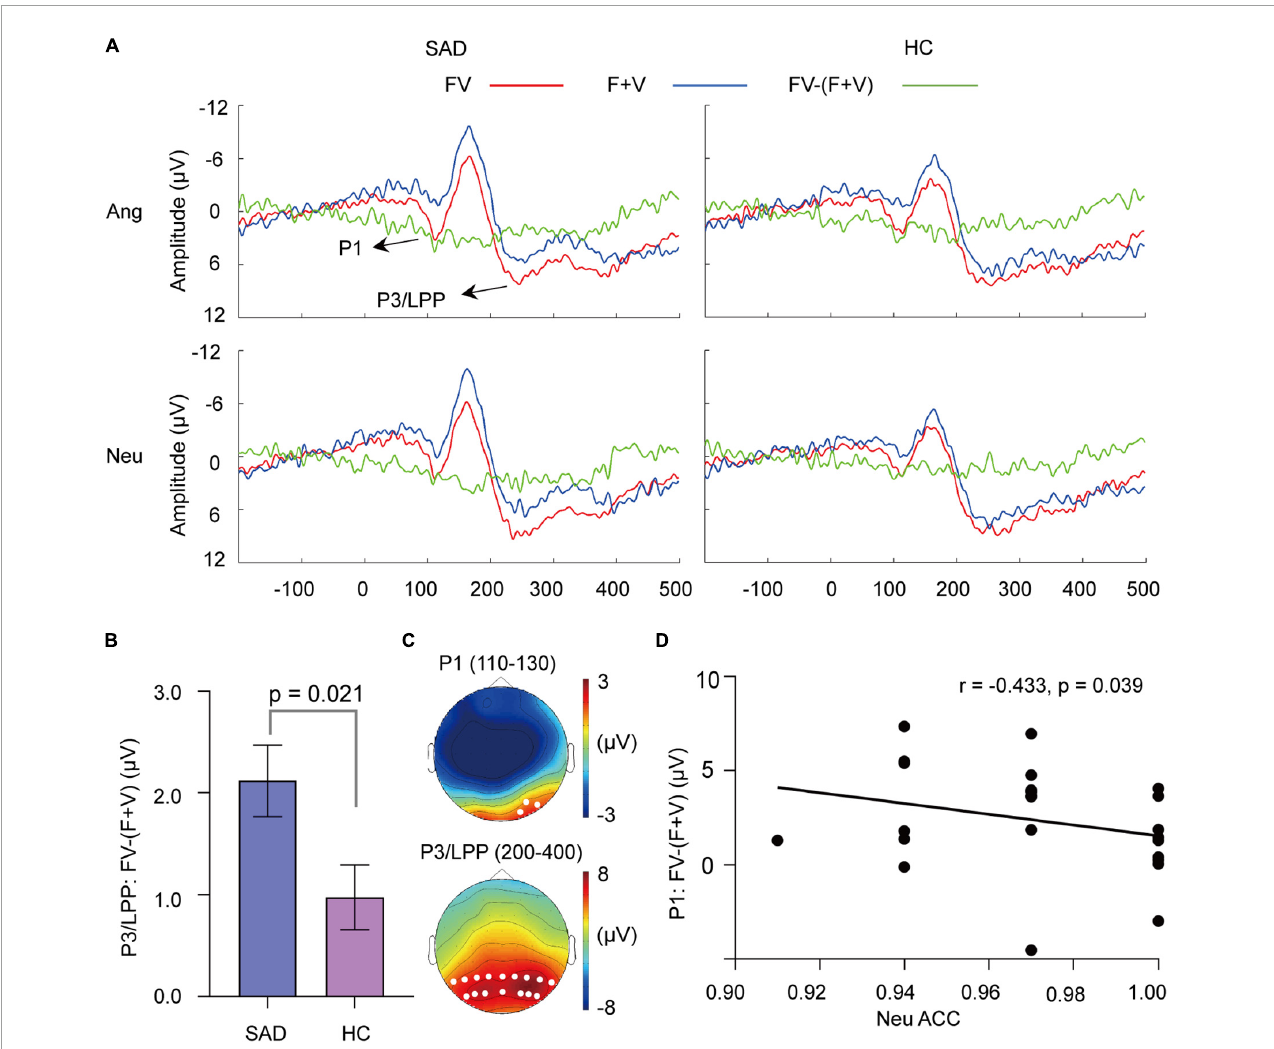
FIGURE5 The superadditivity of ERPs. (A) The grand-averaged waveforms under the FV and (F + V) conditions and their difference waves [FV–(F + V)]. (B) The mean values of [FV–(F + V)] on P3/LPP amplitude for the SAD and HC groups. Error bars indicate ± SEM. (C) The topographies of P1 and P3/LPP under FV condition for the SAD group in neutral trials as an example. The white dots indicate the representative electrodes of the components. (D) The scatter plot of the categorization accuracy to neutral FV stimuli and values of [FV–(F + V)] on the P1 amplitude in neutral trials for the SAD